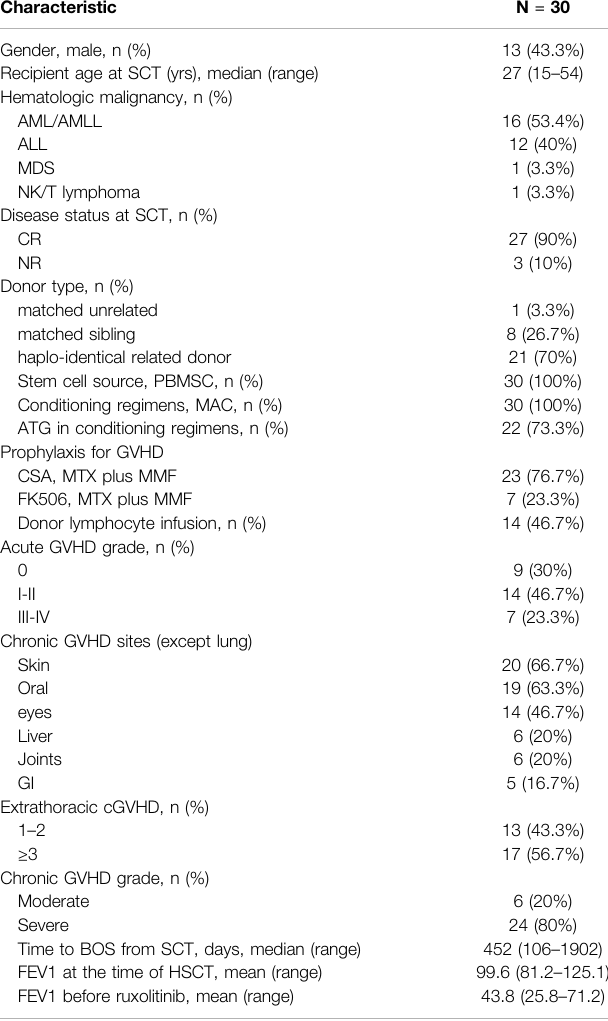
TABLE 1 | Characteristics of the study cohort at baseline.